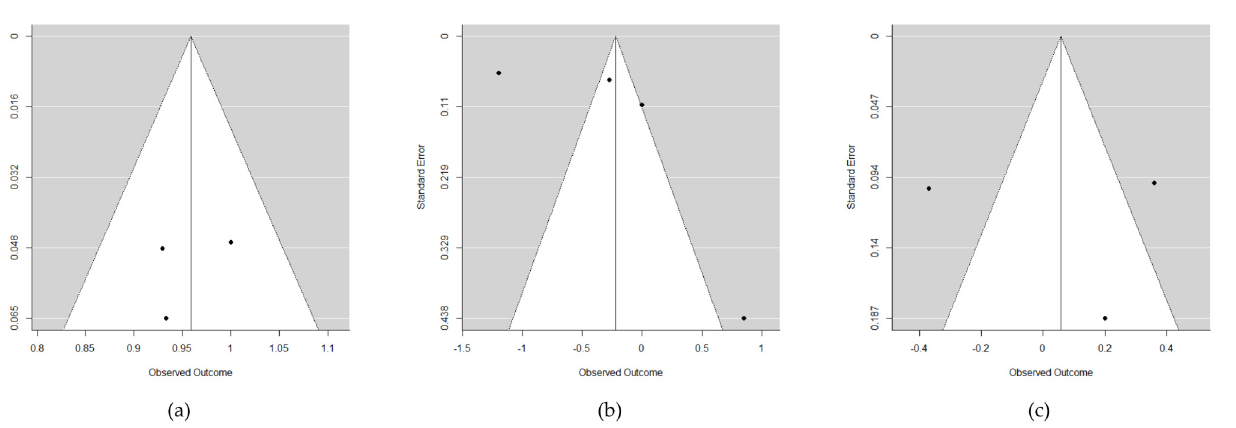
Figure 4. Funnel plots showing the risk of bias referring to ( a ) success rate; ( b ) marginal bone level changes; ( c ) soft tissue recession.